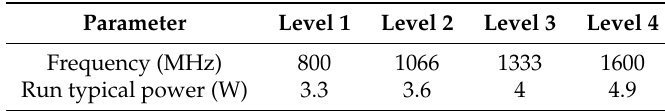
Table 11. Frequency levels of the cortex-A7 core.